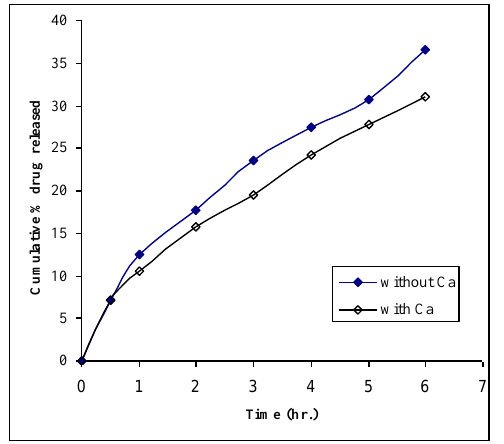
Figure (5): Effect of added Ca ++ ions on the release of naproxen from 1.0% (w/v) pectin gels.